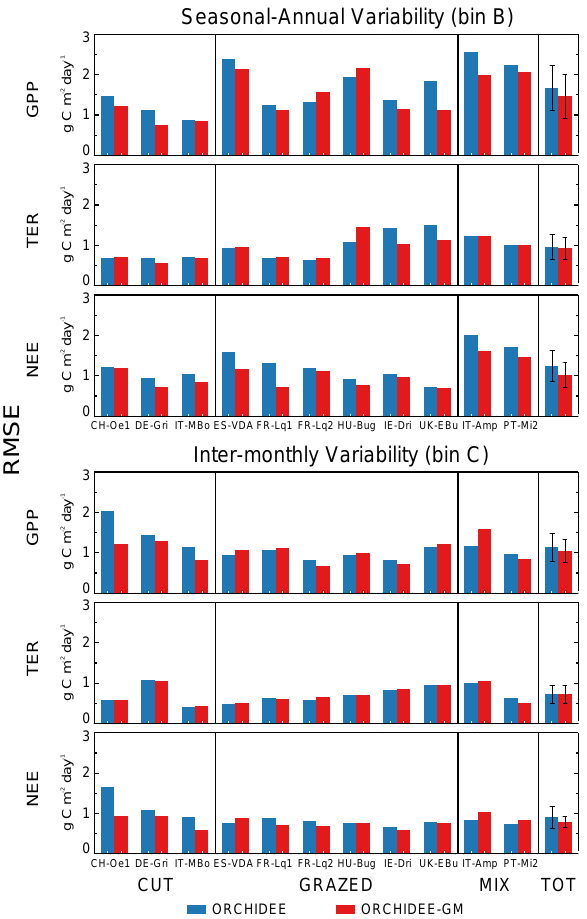
Fig. 7. Barplot of the root mean squared error (RMSE) be- tween modeled and observed CO 2 fluxes (GPP, TER and NEE) on seasonal–annual variability and intermonthly variability. Three management types (cut, grazed and mix-managed) are distin- guished. TOT: the mean RMSE and its standard deviation based on all the sites.